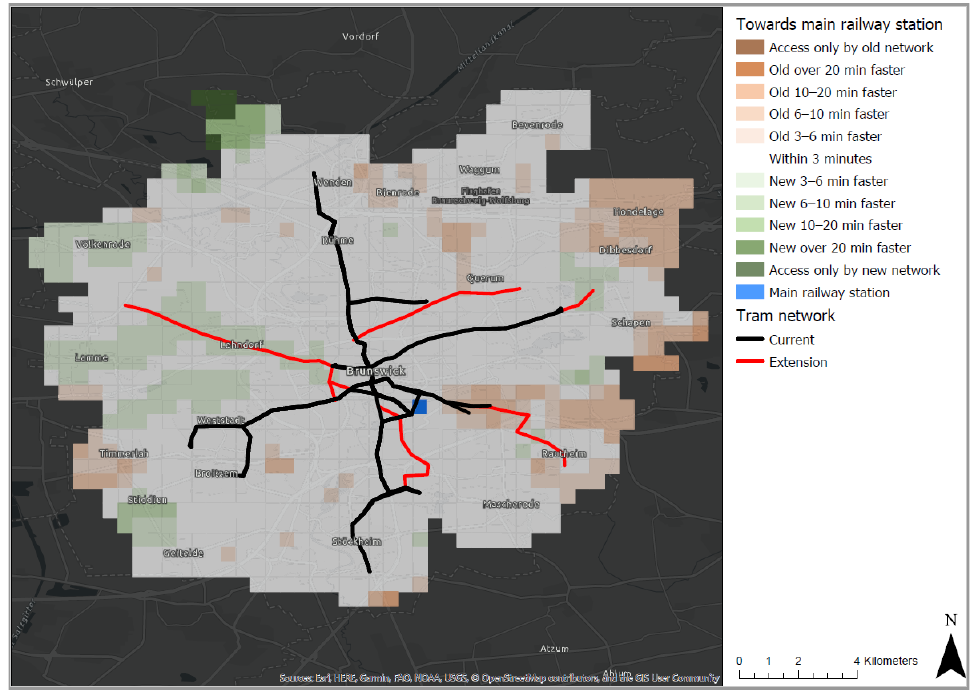
Figure 6. Difference on time taken to reach the main railway station in Braunschweig, Germany.